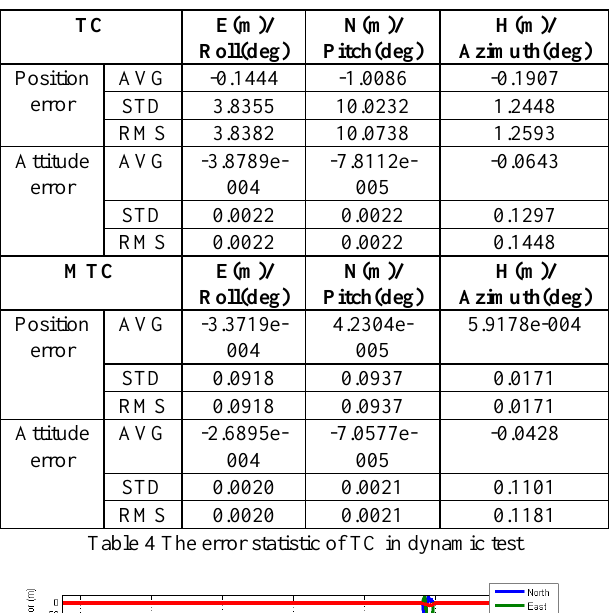
Figure 14 The TC error of POS